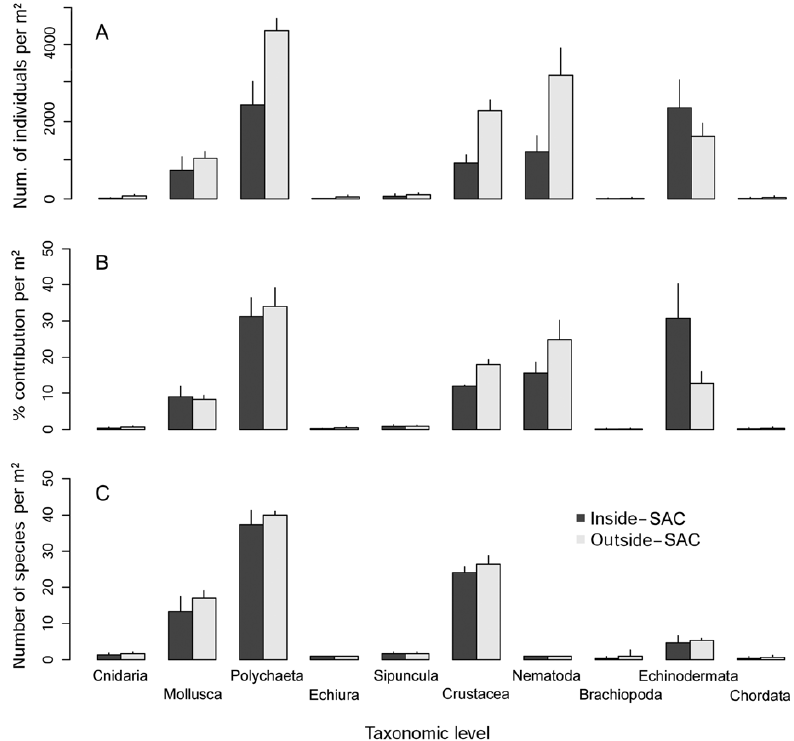
Fig. 2. Number of individuals (A) , percentage contribution (B) , and species (C) per m 2 and per taxonomic level inside and outside the SAC (mean ± SD).